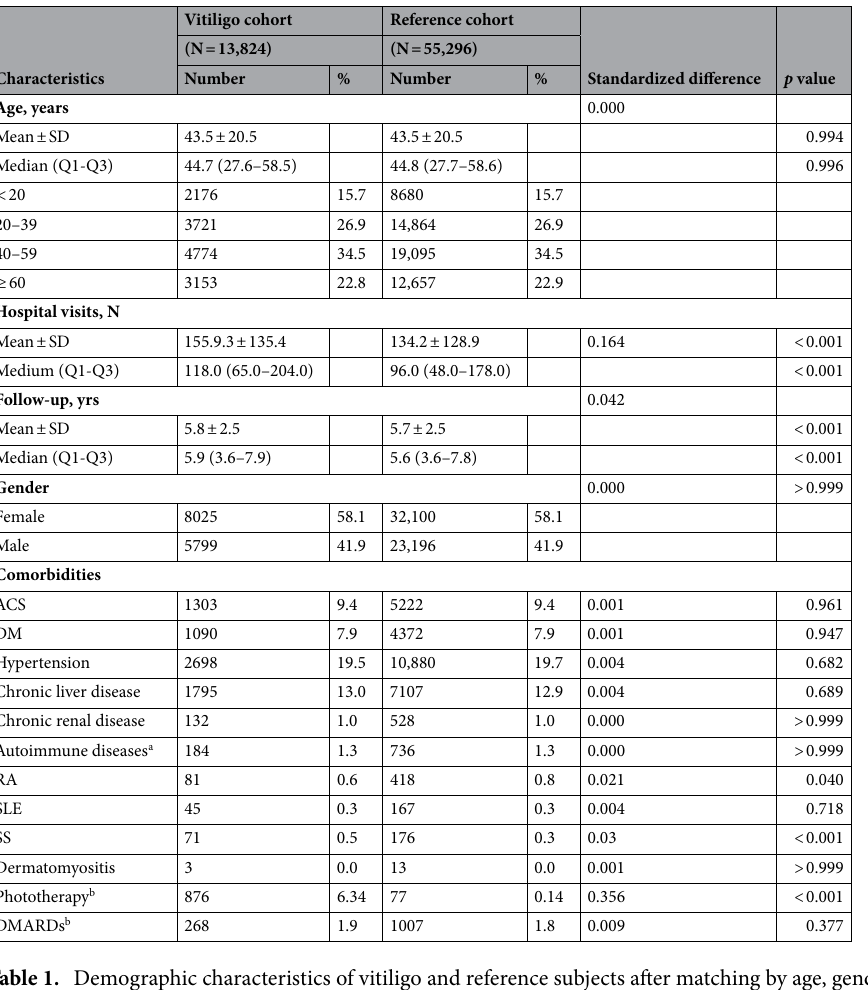
Table 1. Demographic characteristics of vitiligo and reference subjects after matching by age, gender and propensity score. SD standard deviation, yrs years, ACS acute coronary syndrome, BCC basal cell carcinoma, DM diabetes mellitus, DMARDs disease modifying antirheumatic drugs, N number, RA rheumatoid arthritis, SLE systemic lupus erythematosus, SS sicca syndrome, SCC squamous cell carcinoma. Propensity score matching on the factors including ACS, DM, hypertension, chronic liver disease, chronic renal diseases and autoimmune diseases. a Autoimmune diseases include RA, SLE, SS, and dermatomyositis, all of which are registered in the catastrophic illness dataset. b Phototherapy indicated receiving phototherapy including ultraviolet B (UVB) or psoralen-UVA for more than 100 sessions during observation time. Long term DMARDs indicated using systemic DMARDs for more than 30 days on average per year of